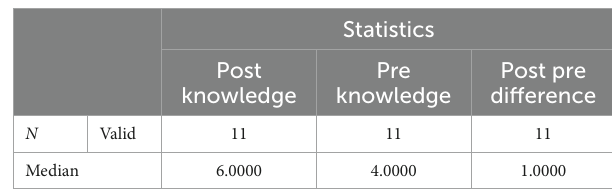
TABLE 1 Median values for posttest, pretest, and differences in post- pretest knowledge scores for self-guided group.